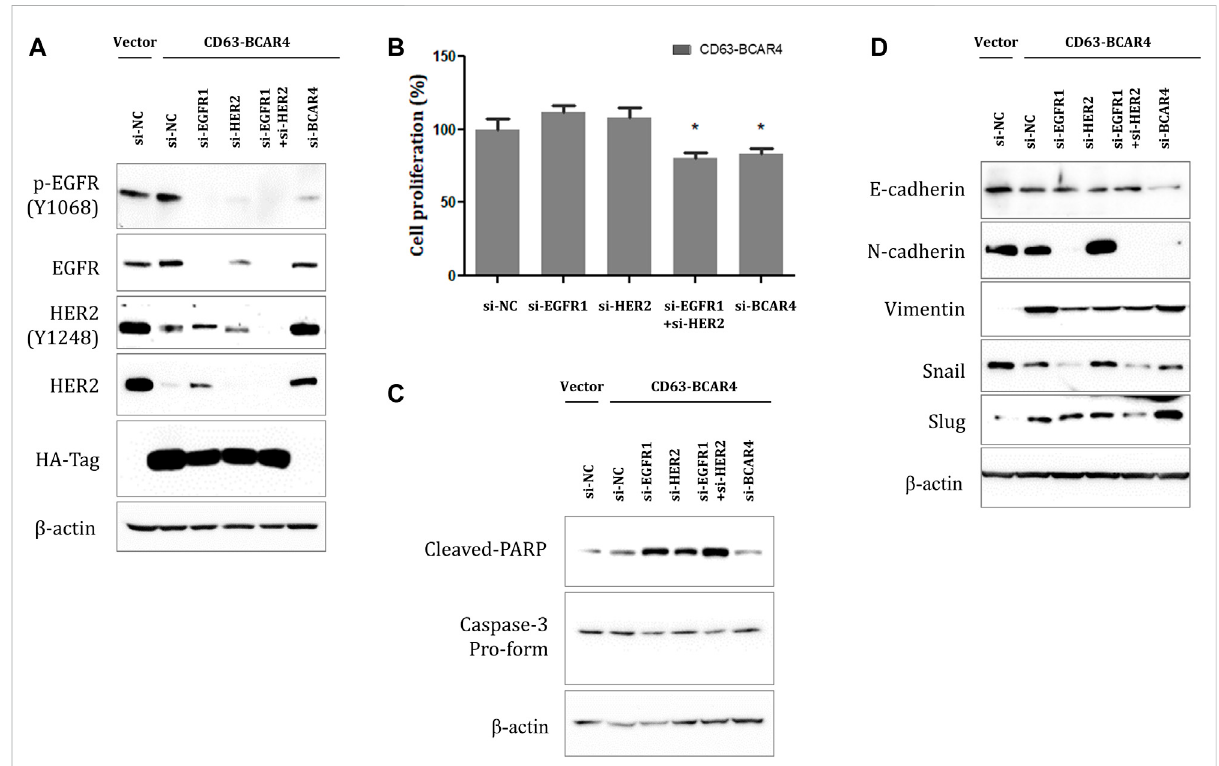
FIGURE 6 EffectsofdualinhibitionofEGFR/HER2onCD63-BCAR4. (A) ProteinlevelsofEGFR,HER2,andtheirphosphorylatedformswereexaminedafter siRNA-mediated knockdown of their expression in CD63-BCAR4 overexpressing cells. (B) Cell proliferation was evaluated in fusion overexpressing cellsaftertransfectionofspeci fi csiRNAs.Thebargraphshowscellproliferation(%)aftertransfectionofsiRNAscomparedwithanegativecontrol(si- NC).*indicates p -valueslessthan0.05. (C) Cleaved-PARPandcaspase-3proteinlevelswereassessedusingwesternblotanalysis. (D) Effectsof siRNAs targeting EGFR and/or HER2 on EMT-related proteins were evaluated using western blot